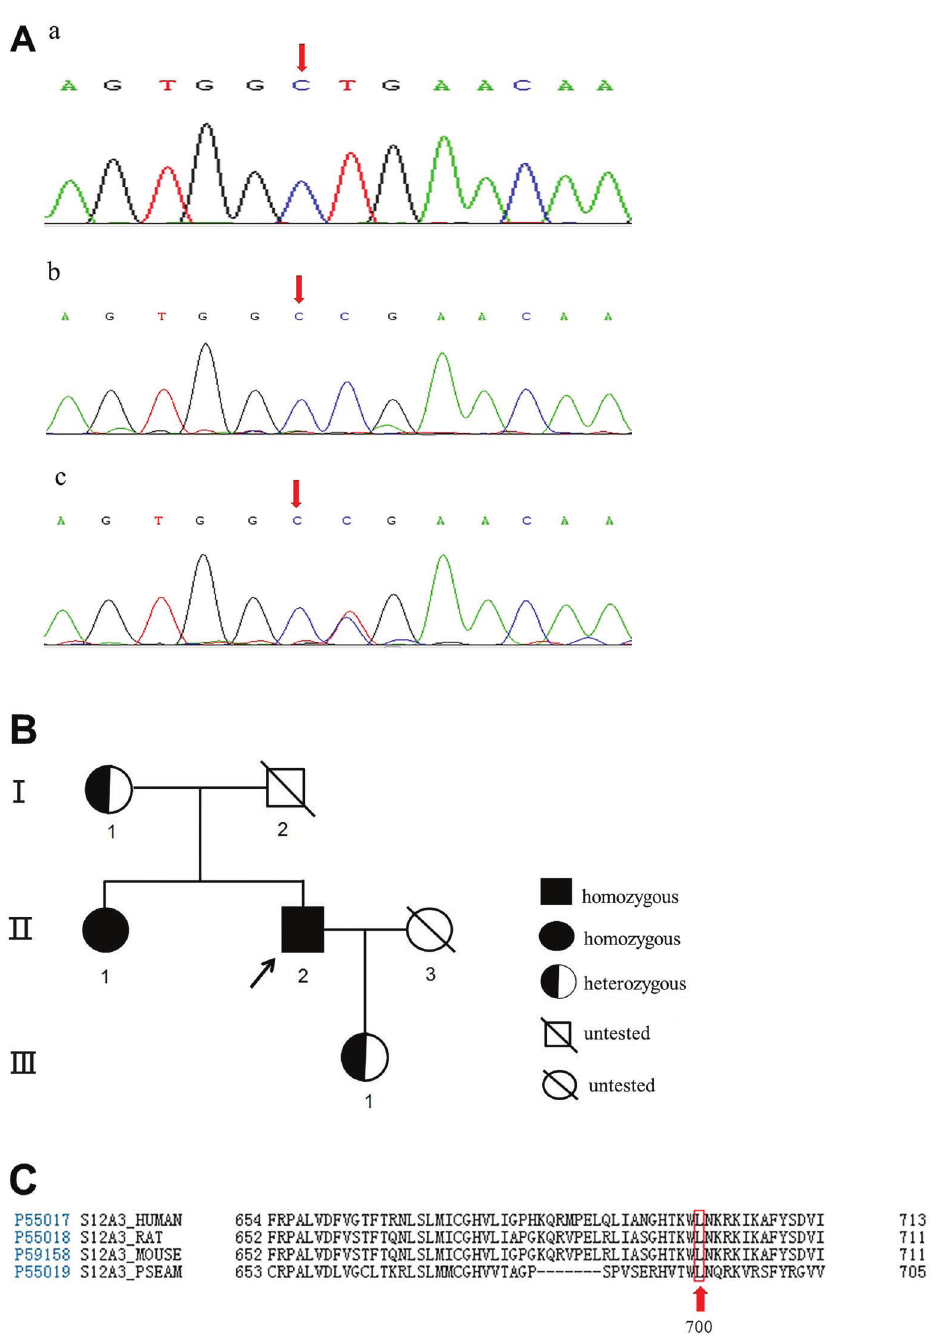
Figure 1. A , mRNA sequences diagram of mutant SLC12A3 gene in the studied pedigree: a , mRNA sequences of wild type; b , mRNA sequences of the patient ’ s mother and daughter, who have heterozygous mutations (in exon 17, c.2099T 4 C, CTG CCG, leading to Leu700Pro); c , mRNA sequences of the patient and his sister, who have homozygous mutations. B , family pedigree chart. C , analysis of amino acid conservation across various species (human, rat, mouse and Pleuronectes americanus ), indicating that the mutation (amino acid residue 700 encoding leucine) was located in the highly conserved amino acid